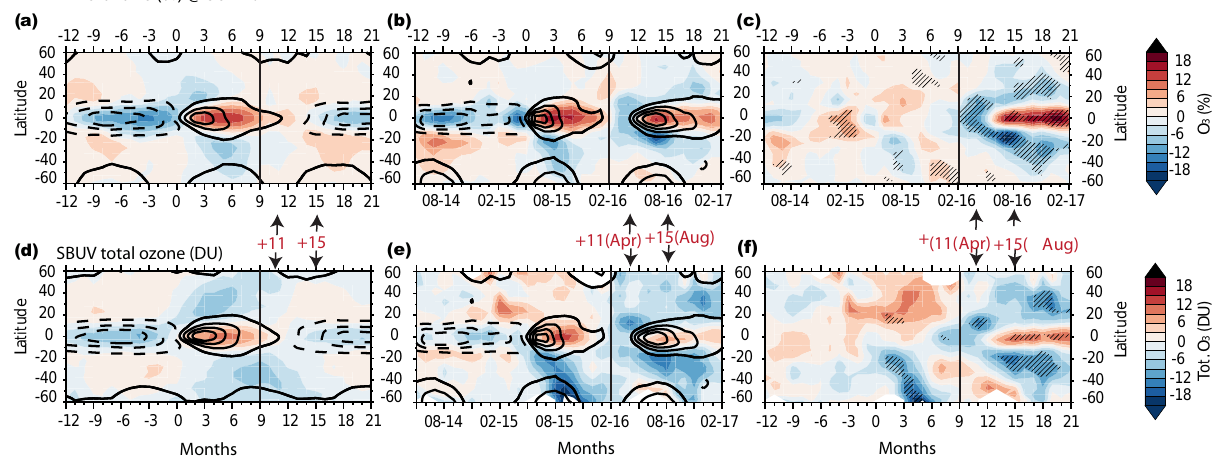
Figure 3. Latitude and time evolution of MLS ozone at 38hPa (top row) for (a) the composite, (b) 2015–2016, and (c) their difference (b–a) , highlighting the anomalies due to the disruption. MLS ozone values are shown in percent change from long-term monthly averages with contour intervals every 3% (zero contour is omitted). The bottom row shows the deseasonalized SBUV total ozone (in Dobson units, contour intervals every 3DU) for (d) the composite, (e) 2015–2016, and (f) their difference (e–d) . Black thick solid and dashed contours show westerly and easterly vertical wind shear, respectively, for (a, d) the composites and (b, e) 2015–2016. MLS (SBUV) composites are based on 4(14) transitions from easterly to westerly vertical wind shear at 40hPa. Vertical black line highlights + 9 months after wind shear reversal from negative to positive (month 0), corresponding to February 2016 in (b) and (e) , while arrows indicate ozone at + 11 and + 15 months after month 0, corresponding to April 2016 and August 2016 in (b) and (e) . Gray hatching in (c) and (f) indicates regions with the absolute difference between 2015–2016 and the composites being larger than 2 standard